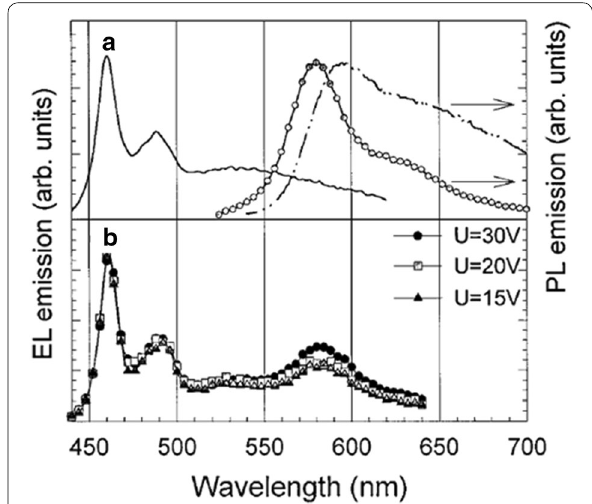
Fig. 4 a EL spectra of m -LPPP (solid line) and the PL spectra of PPDB in solid state (dashed line) and solution form (circles). b EL spectra of the WPLED at different applied voltage (Reproduced with permission